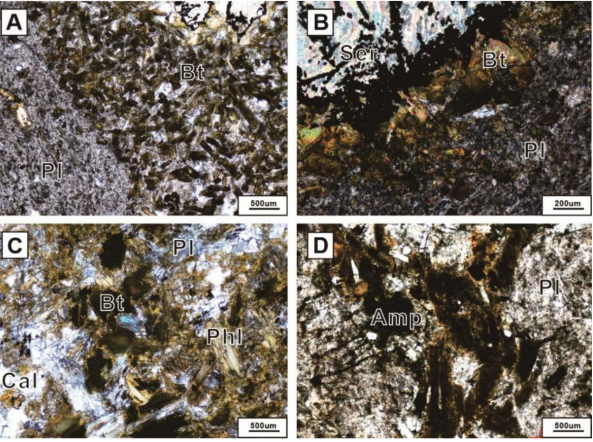
Figure 4. Photomicrographs of the lamprophyres. ( A ) kersantite; ( B ) biotite phenocryst in kersantite; ( C ) damkjernite; ( D ) spessartite. Mineral abbreviations: Amp—amphibole; Bt—biotite; Cal—calcite; Pl—plagioclase; Phl—phlogopite;